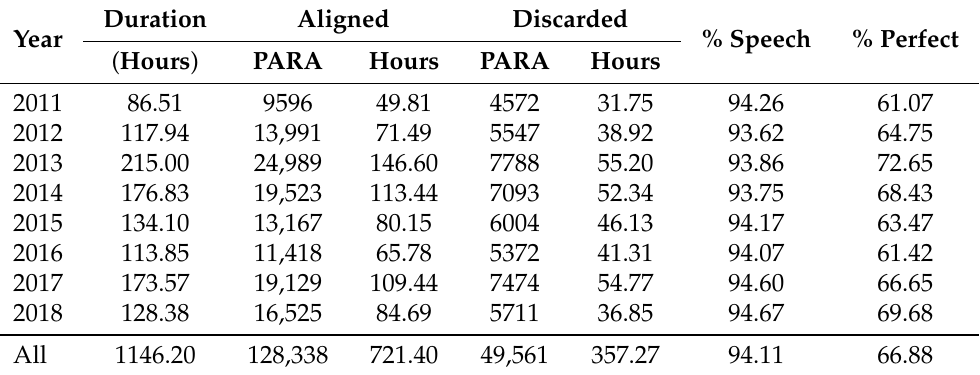
Table 3. Forced alignment results at the paragraph level. PARA indicates the number of paragraphs, % speech the percentage of identified speech in the audio, and % perfect the percentage of perfectly aligned content within identified